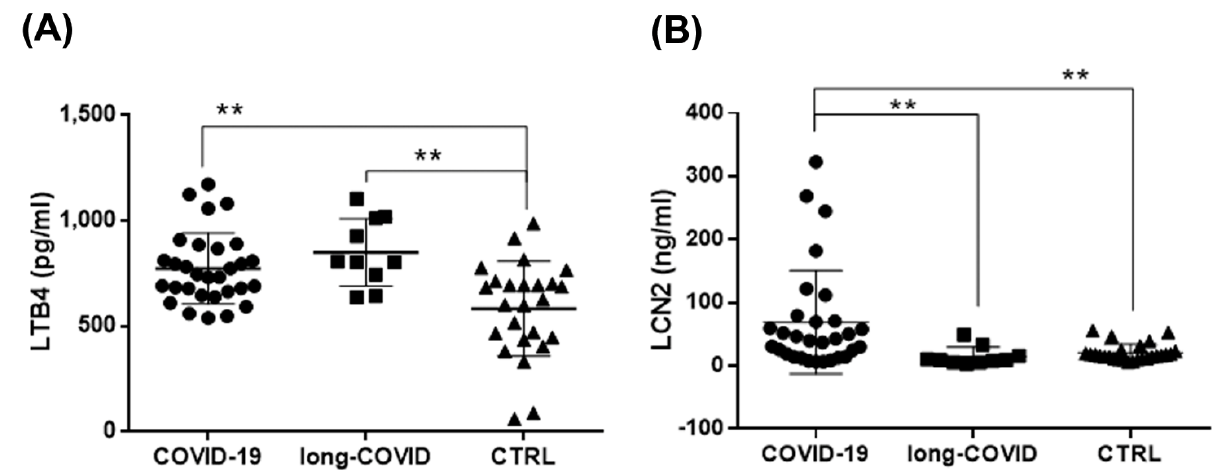
Figure 4. Increased LTB4 and LCN2 systemic levels in COVID-19 and long-COVID patients. ( A , B ) Plasma levels of LTB4 and LCN2 in COVID-19 patients (n = 30), long-COVID-19 patients (n = 10), and healthy donors (n = 25) were analyzed using ELISA. Data reported in this figure are the mean ± SE of two independent experiments (** p < 0.01).